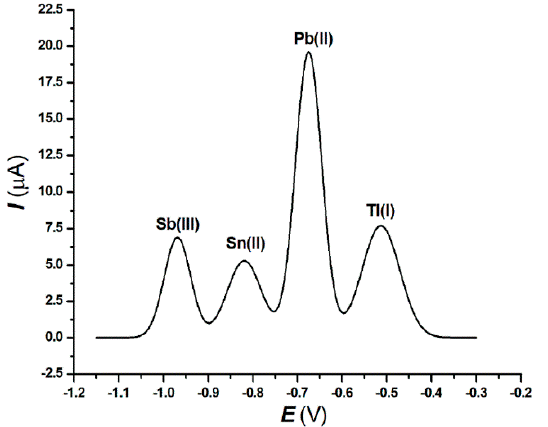
Figure 2. Square wave anodic stripping voltammograms of Tl(I), Pb(II), Sn(II) and Sb(III) in Taraxacum officinale weber . Experimental conditions: see Section 2.3. Supporting electrolyte: 0.5 mol L − 1 ammonium citrate buffer pH 6.5 + 7.3 · 10 − 3 mol L − 1 EDTA-Na 2